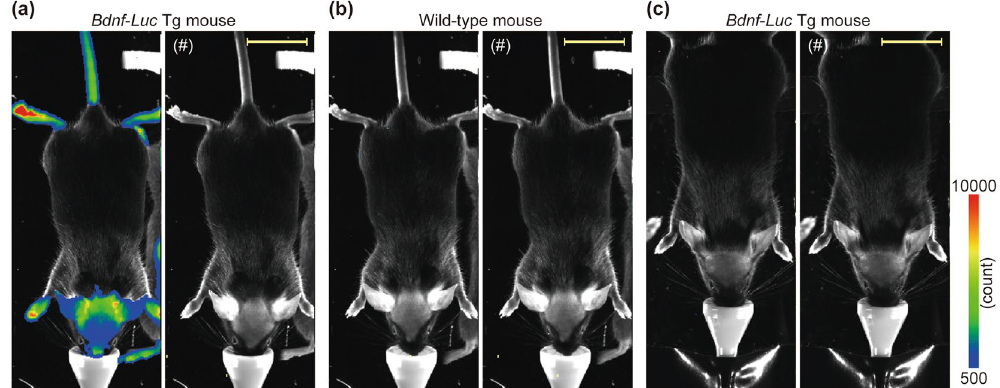
Figure 3. In vivo bioluminescence imaging using Bdnf - Luc Tg mice. The fur on the head of the mouse was shaved before in vivo bioluminescence imaging. The imaging was performed using Bdnf - Luc Tg ( a , c ) and wild- type ( b ) mice. Ten minutes after intraperitoneal administration of d-luciferin (150 mg/kg body weight, a , b ) or saline ( c ) under anesthesia, the bioluminescence was measured by in vivo imaging (Exposure: 2 min). The intensity of the bioluminescence signal is shown in pseudocolored images. The photograph of the Tg or wild- type mouse (indicated by (#)) was merged with the pseudocolored image. Scale bar = 20 mm. The experiment was performed independently at least four times, and the same tendency was